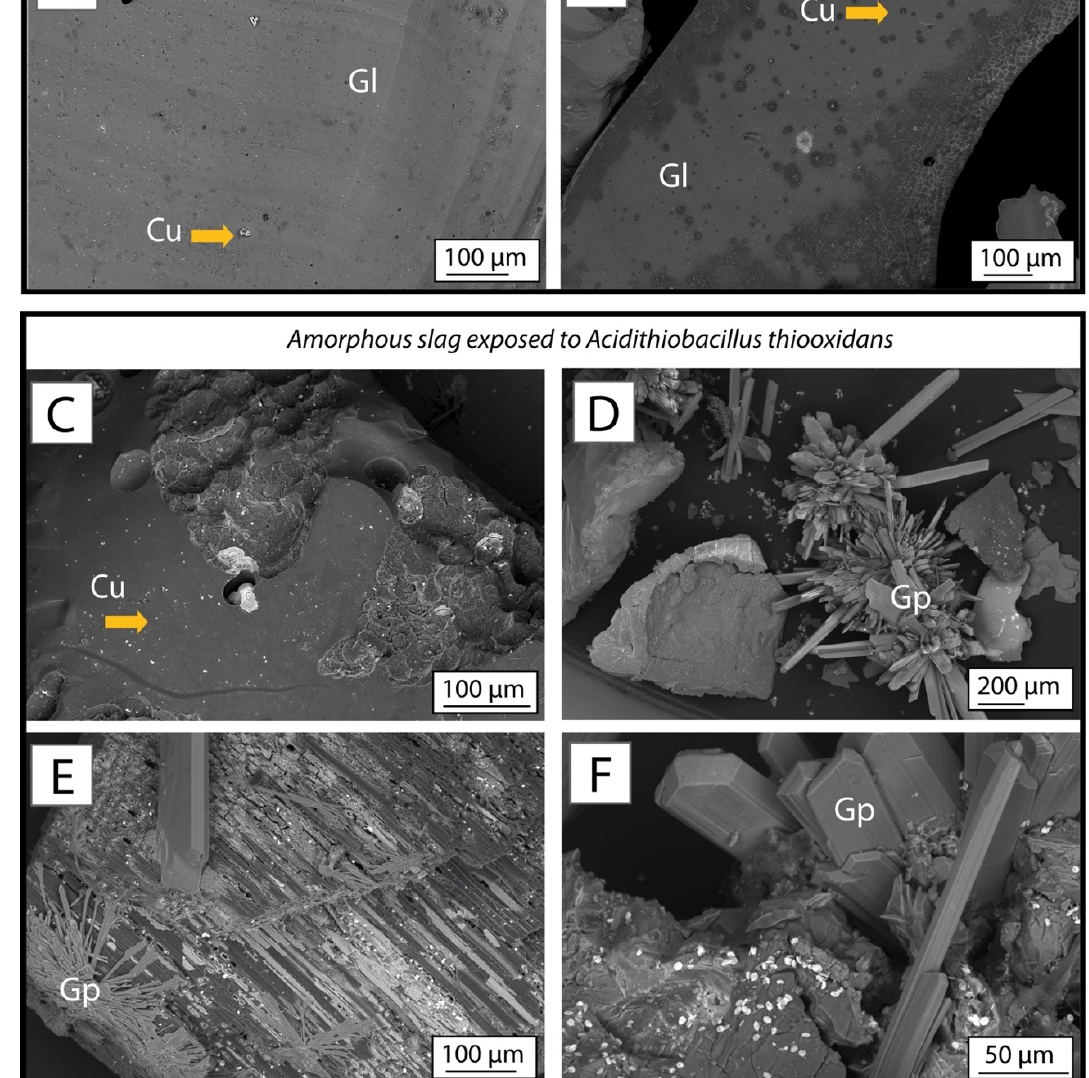
Figure 8. Scanning electron microscope images of AS leached during 21 days in abiotic growth medium and biotic solution with A. thiooxidans. Abbreviations: Gl: glass, Cu: metallic copper, Gp: gypsum. ( A ) and ( B ): Amorphous slag exposed to abiotic growth medium; ( C–F ): Amorphous slag exposed to Acidithiobacillus thiooxidans .